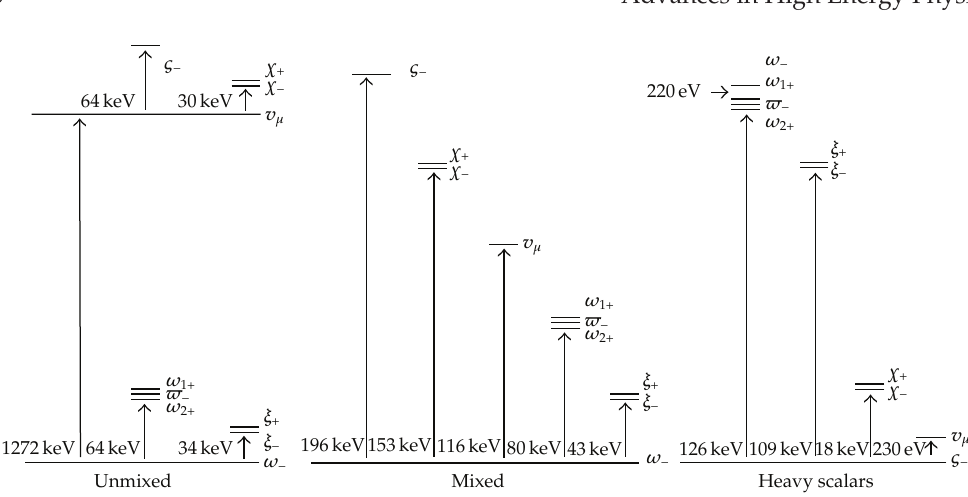
Figure 2: The ground state spectrum of the three benchmark models. In all cases, the small, unlabeled splittings are of order B (cid:14)